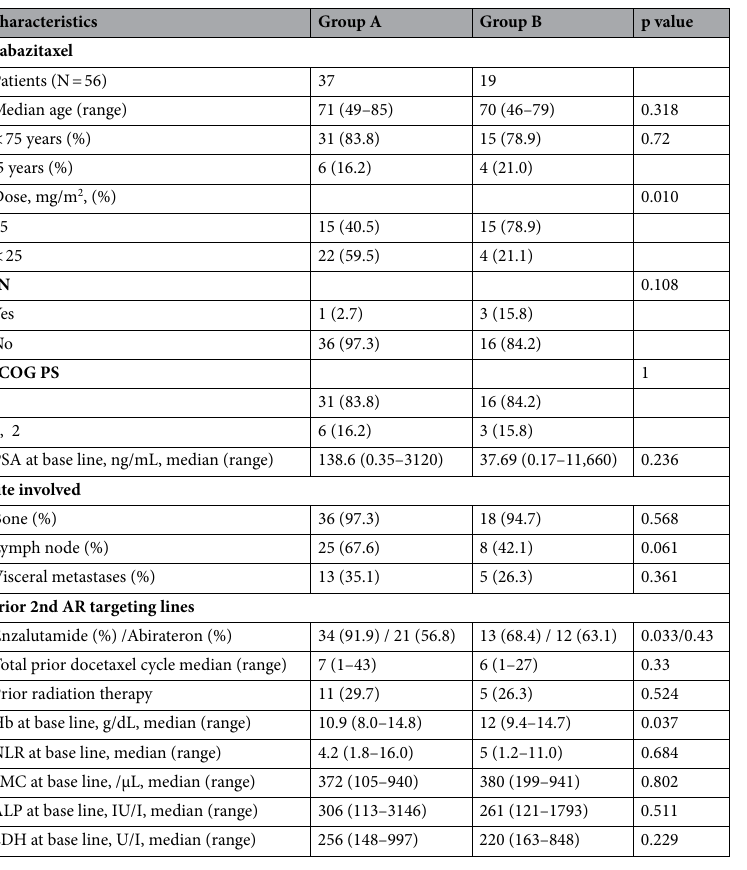
Table 2. Characteristics of patients between the group with all cycles with prophylactic antibiotics and the group with cycles without prophylactic antibiotics. Group A, patients with all cycles of prophylactic antibiotics. Group B, patients with cycles without prophylactic antibiotics. FN, febrile neutropenia; ECOG PS, Eastern Cooperative Oncology Group performance status; PSA, prostate-specific antigen; AR, androgen receptor; Hb, hemoglobin; NLR, Neutrophil to Lymphocyte ratio; AMC, absolute monocyte count; ALP, alkaline phosphatase; LDH, lactate